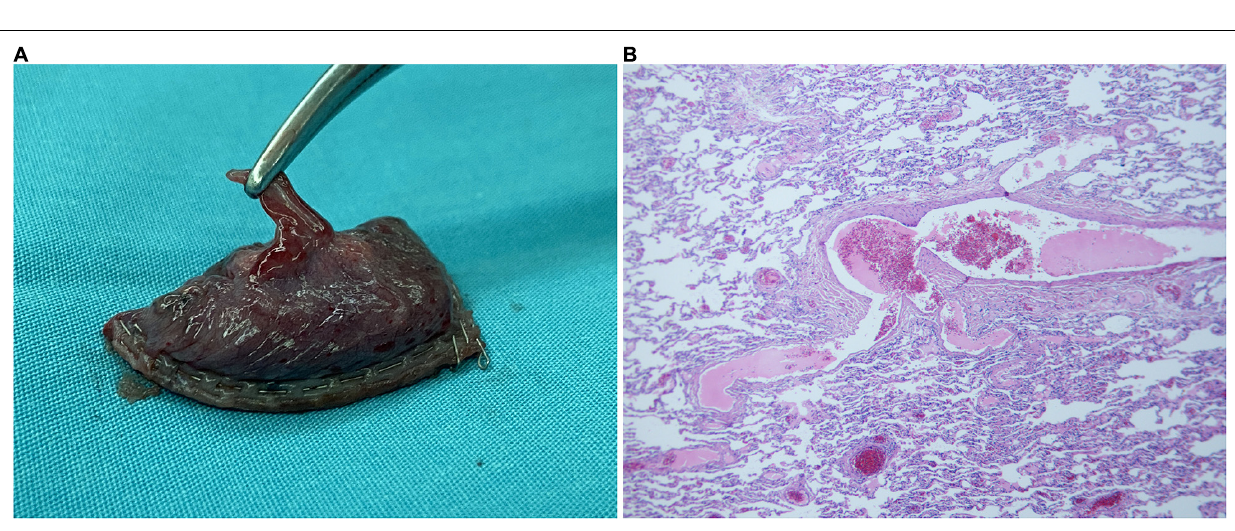
FIGURE 4 | Pathological specimen and microscopic findings. (A) The abnormal supply vessel in the upper lobe apical segment of the left lung is ruptured, with a diameter of 2 mm. The surrounding lung tissue erodes and appears red. (B) There are many lymphocytic infiltration in the pulmonary interstitium along with mild hyperplasia of the pleural fibrous tissue. Numerous foam cells, cholesterol crystals, and multinucleated giant cell reactions are seen in the alveoli near the